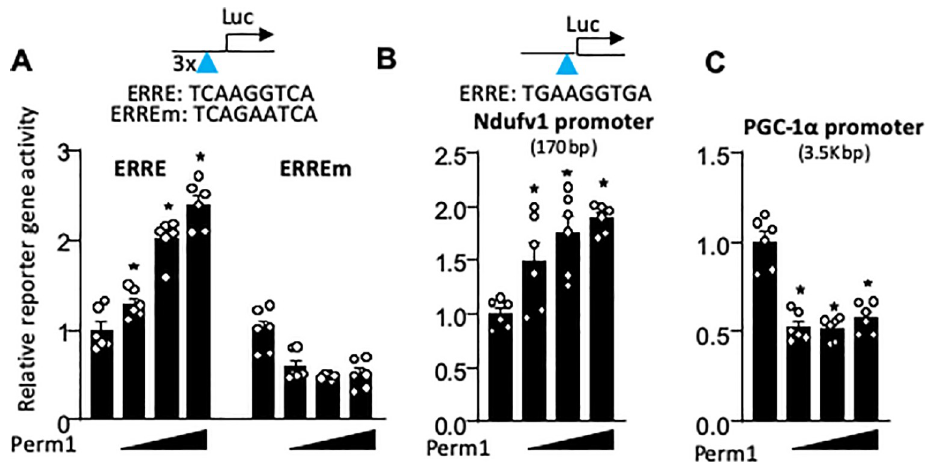
Fig 6. Perm1 activates the promoters of ERR α and its target gene through the ERRE. (A) Luciferase reporter assays showing that Perm1 increases ERRE activity ( TCAAGGTCA ) in a dose-dependent manner, whereas mutant ERRE (mERRE, TCAGAATCA ) is not be activated by Perm1. (B) Perm1 activates the ERRE within the Ndufv1 promoter (a subunit of Complex I, an ERR α target gene) in a dose-dependent manner. Note that the ERRE in mouse Ndufv1 promoter is TGAAGGTGA . (C) Perm1 does not increase the promoter activity of PGC-1 α but rather represses the gene (n = 5/group). Statistics were performed using the t-test with 2 tails ( � p < 0.05). Error bars are ± SEM.